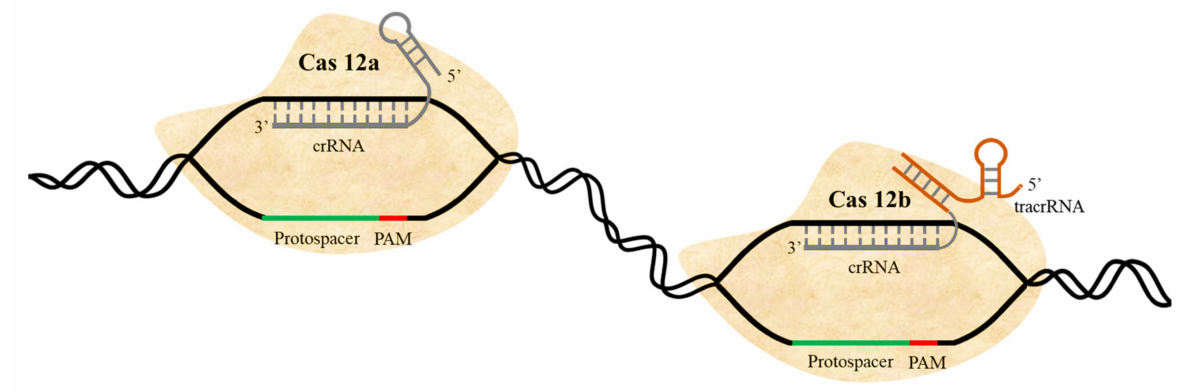
Figure 3. Schematic diagram of CRISPR/Cas12a and 12b. Both bind with target DNA upstream of PAM to induce DSBs with staggered ends. Cas12a utilizes crRNA. Cas12b utilizes crRNA and tracrRNA.